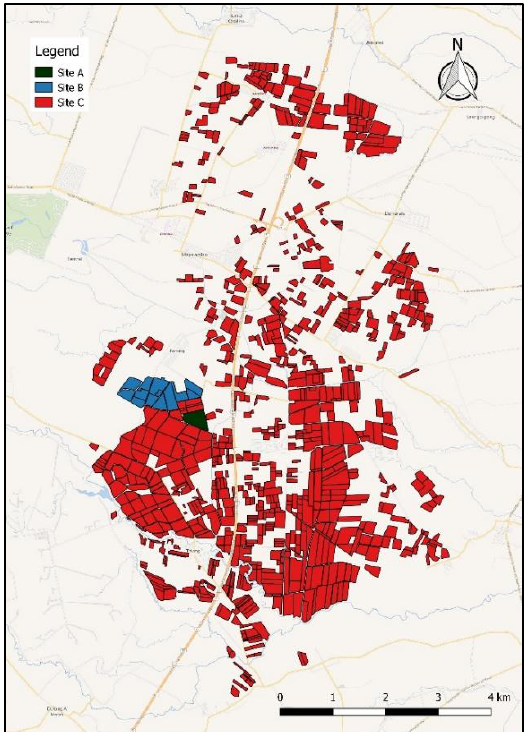
Table 2. DTW parameters and values